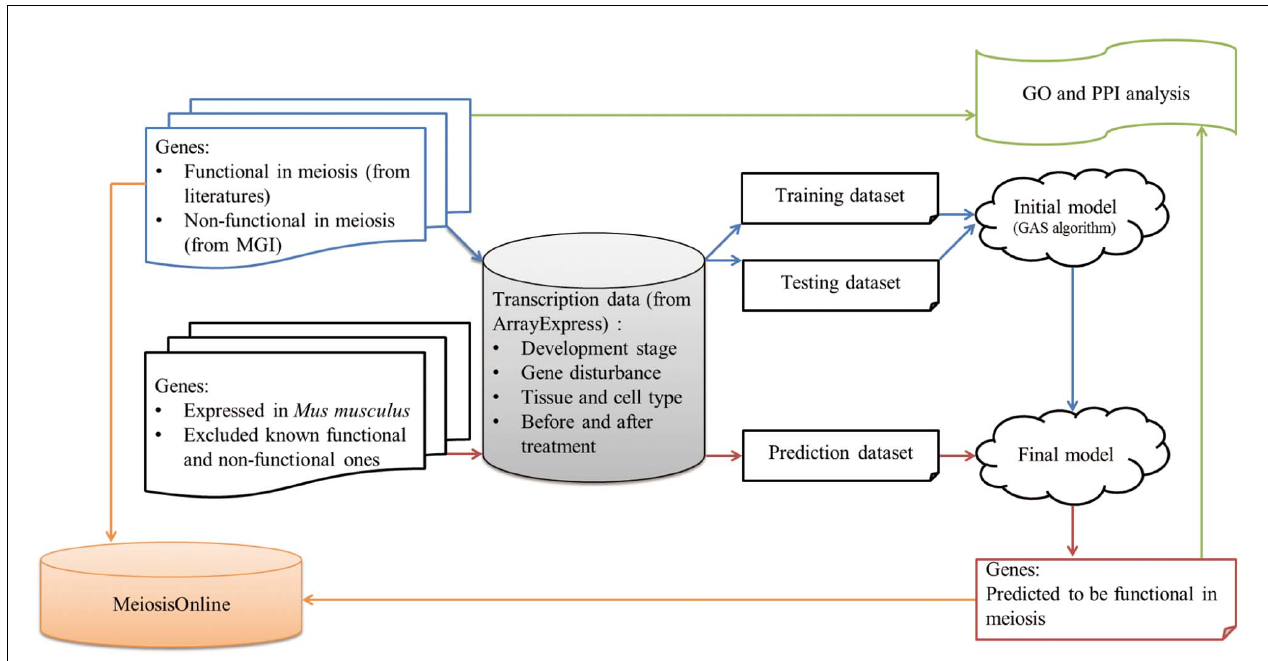
FIGURE 1 | MeiosisOnline database scheme. Manually curated functional genes in meiosis are collected and further incorporated in the MeiosisOnline database.